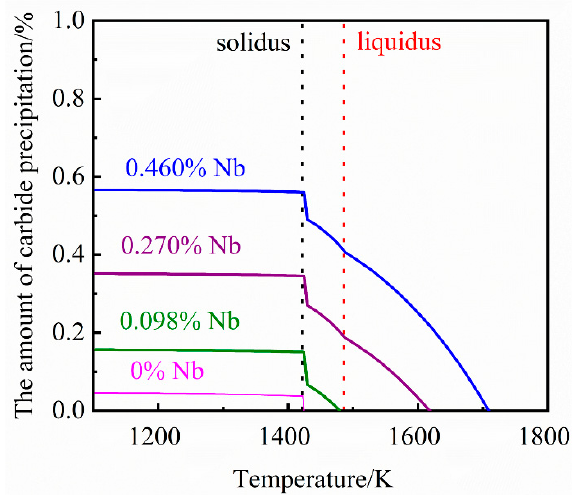
Figure 4. The relationship between different niobium contents and the amount of carbide precipitation.